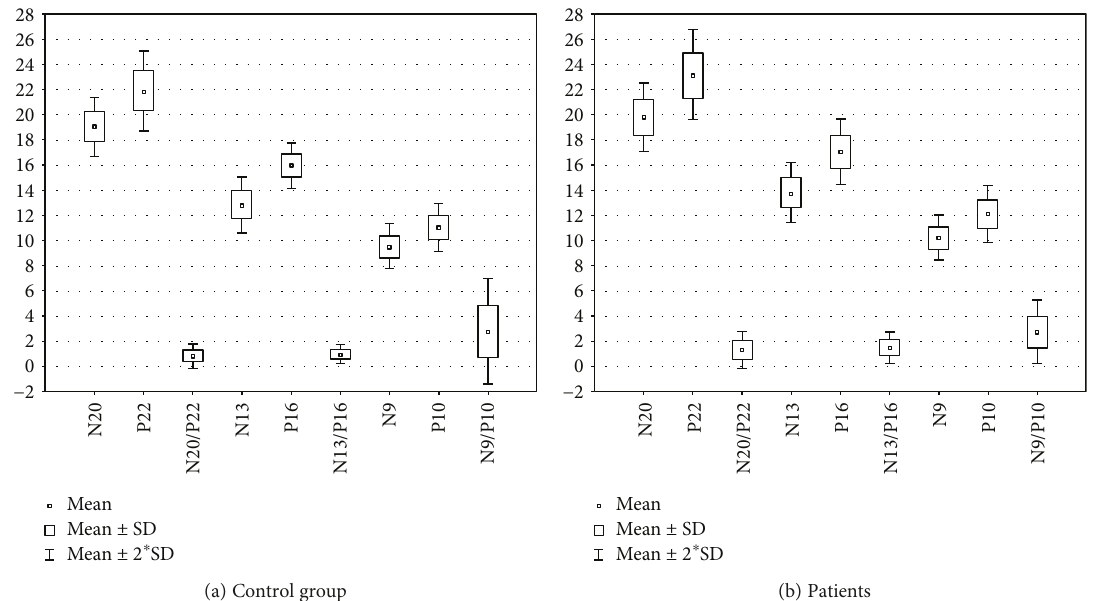
Figure 1: Box plot diagrams for SEP parameters in the (a) control group and (b) study group. Mean: mean standard